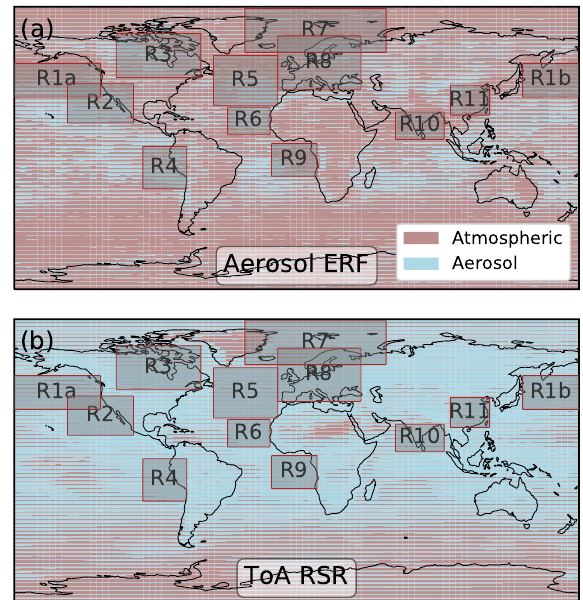
Figure 10. Maps of contributions to variance in (a) 1850–2008 aerosol ERF and (b) present-day (2008) ToA RSR from atmo- spheric and aerosol parameters. Each pixel contains a box that is shaded in proportion to the amount of variance caused by each source of